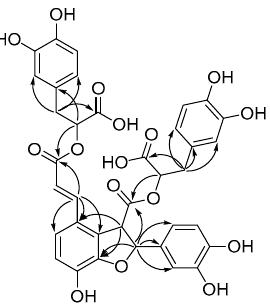
Figure 2. Key HMBC correlations (H → C) of compound 1 .